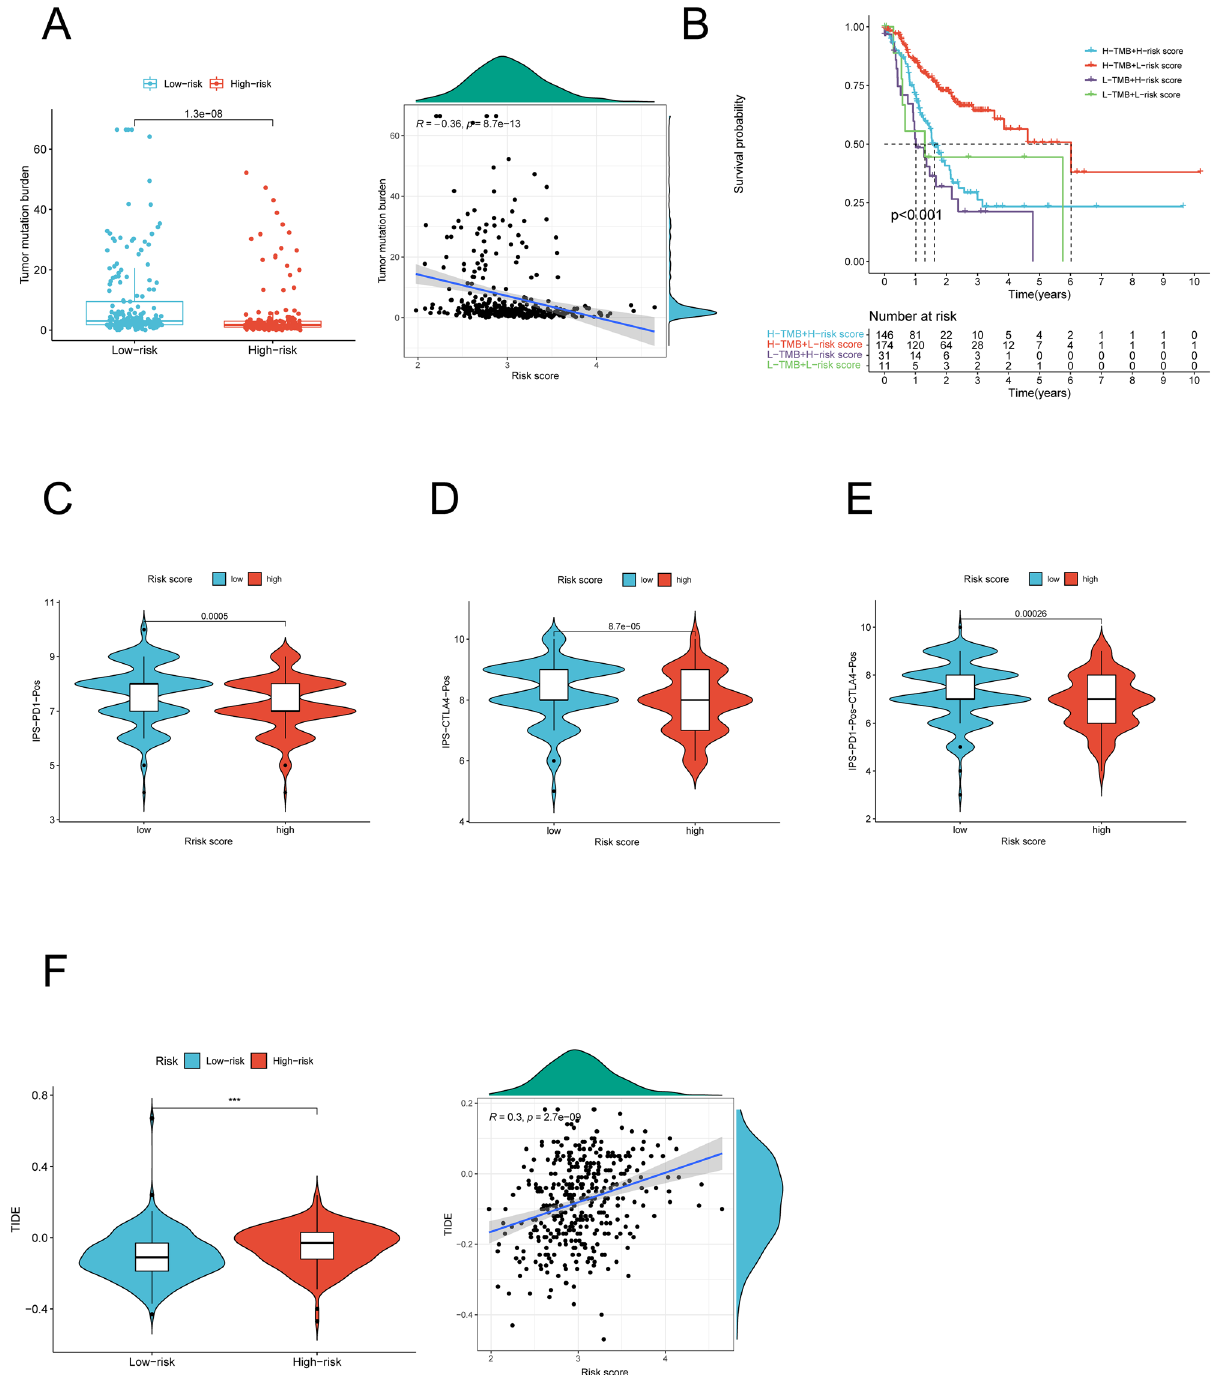
Figure 12. Correlation of risk score with TMB and predictive value of risk score for immunotherapy response. ( A ) TMB differences between the high- and low-risk score groups and the scatter plot depicted a positive correlation between risk score and TMB. ( B ) Kaplan–Meier curves for patients stratified by risk score and TMB in the TCGA-GC cohort. ( C – E ) Immunophenscore (IPS) between high- and low-risk score groups. Blue represents the low-score group and red the high-score group. The thick line within the violin plot represents the median value. The inner box between the top and bottom represents the interquartile range. ( C ) IPS score when PD-1 positive; ( D ) IPS score when CTLA4 positive; ( E ) IPS score when both PD-1 and CTLA4 positives. TMB, tumor mutation burden; IPS, Immunophenscore. ( F ) TIDE score differences between the high- and low-risk score groups and the scatter plot depicted a positive correlation between risk score and TIDE and lower risk score may be more likely to benefit from the immunotherapy (Spearman text, p <